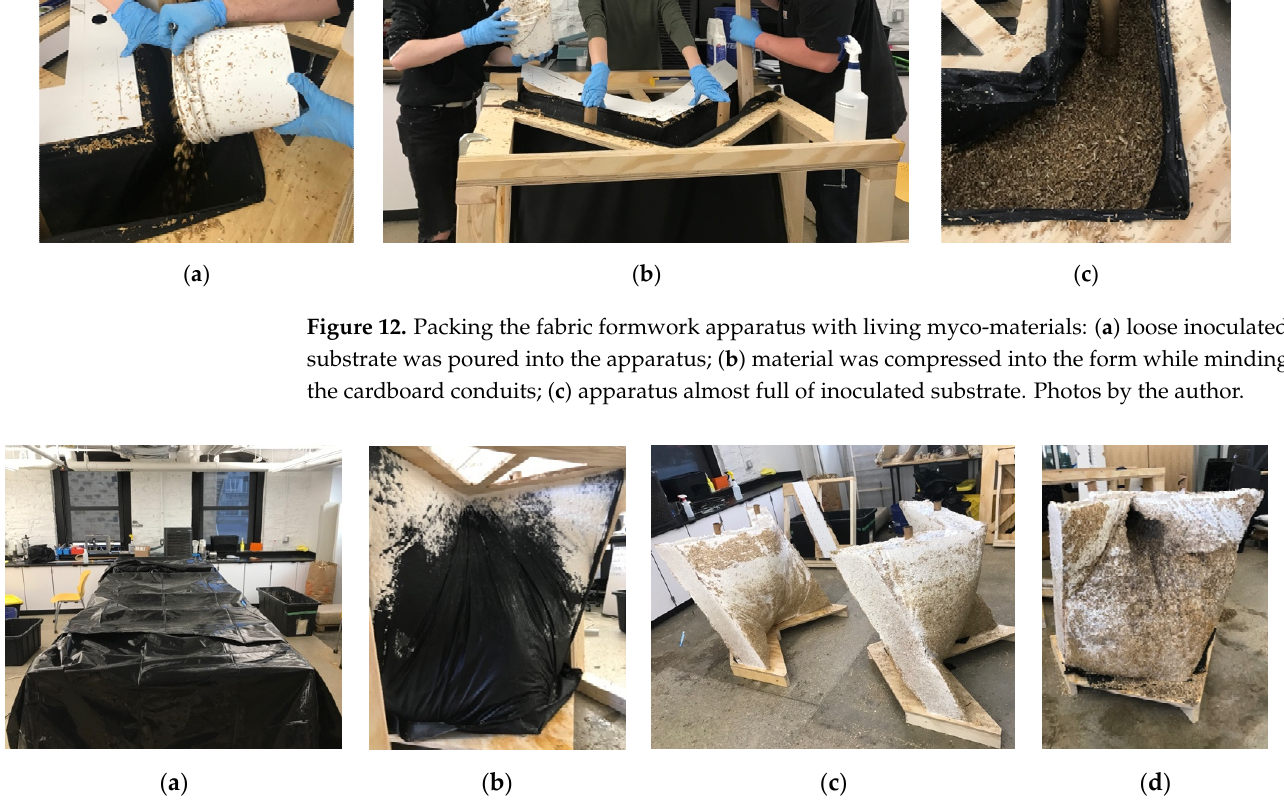
Figure 13. Growing fabric-formed monolithic wall units: ( a ) black plastic covered the formworks as the material grew in the MycoMatters Laboratory; ( b ) after four days of growth, healthy mycelium was found growing through the fabric; ( c ) first two fabric-formed monolithic units with all formworks removed after growing four days; ( d ) third unit found with a contamination compromising mycelial growth deep into the unit. Photos by the author.